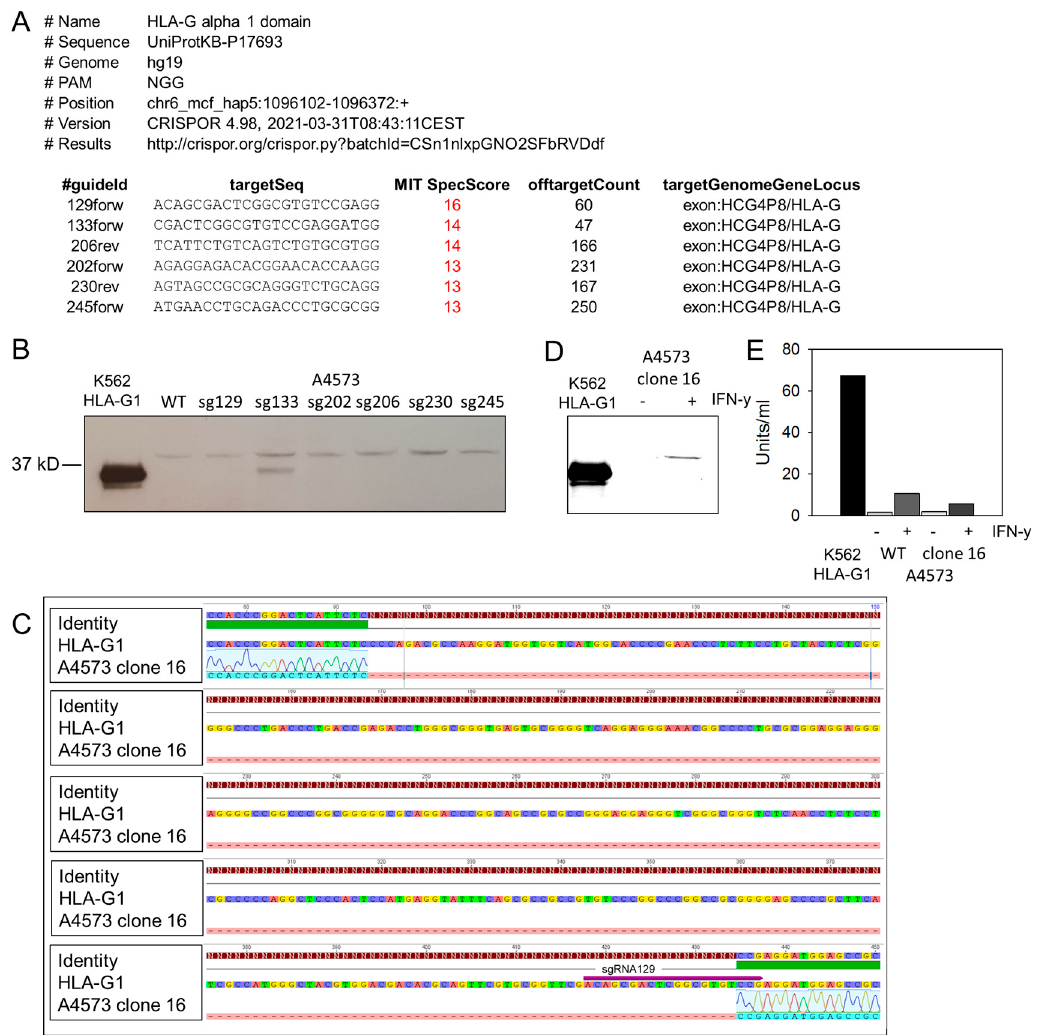
Figure A2. CRISPR/Cas9 knock-out. ( A ) Design of single guide RNA sequences. ( B ) Western Blot analysis of HLA-G expression in whole cell lysates of HLA-G1-transduced K562 cells (positive control) and the CRISPR/Cas9-sgRNA-transduced EwS cell line A4573, following pretreatment with IFN- γ . Wildtype A4573 cells were used as a control. ( C ) Genomic DNA sequence analysis of CRISPR/Cas9-sgRNA 129-transduced EwS cell line A4573 after single cell cloning. ( D ) Western Blot analysis of HLA-G expression in whole cell lysates of HLA-G1-transduced K562 cells (positive control) and the CRISPR/Cas9-sgRNA 129-transduced EwS cell line A4573 after single cell cloning, following pretreatment with IFN- γ or without. ( E ) Expression of HLA-G in whole cell lysates of HLA-G1 transduced K562 cells (positive control) and the CRISPR/Cas9-sgRNA 129-transduced EwS cell line A4573 after single cell cloning, following pretreatment with IFN- γ or untreated, using an ELISA for the isoforms HLA-G1 and G5. Wildtype A4573 cells were used as a control.